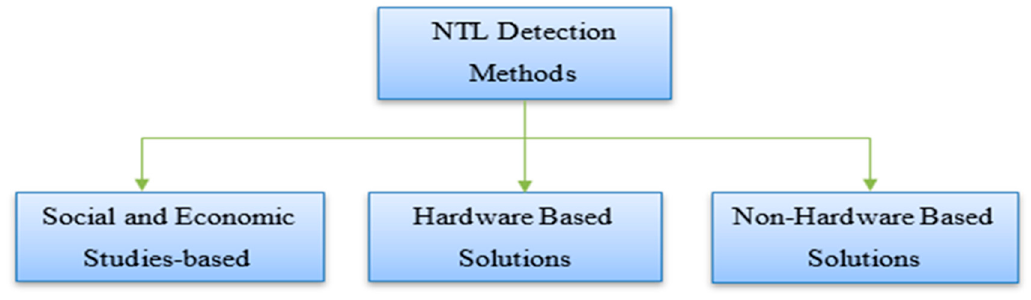
Figure 2. NTL detection methods.